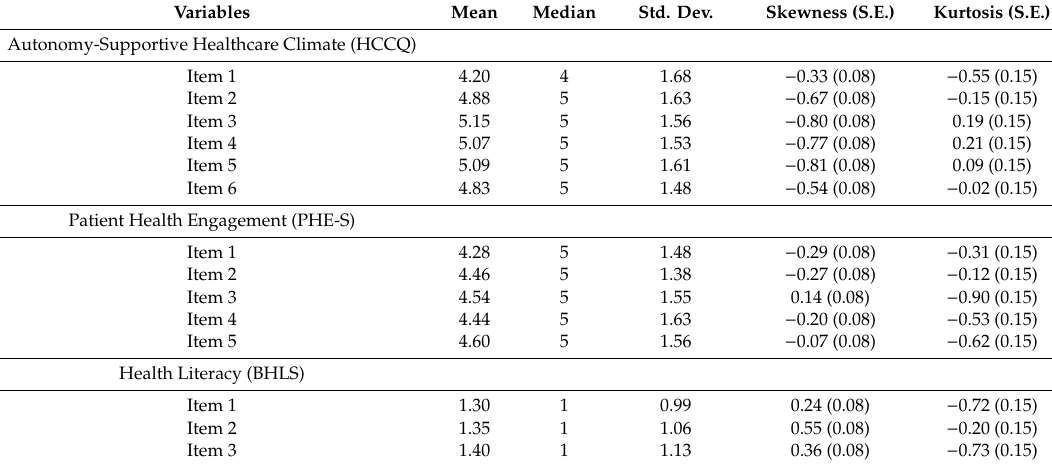
Table 2. Mean, standard deviation, skewness, and kurtosis of the study’s measures. Variables Mean Median Std. Dev. Skewness (S.E.) Kurtosis